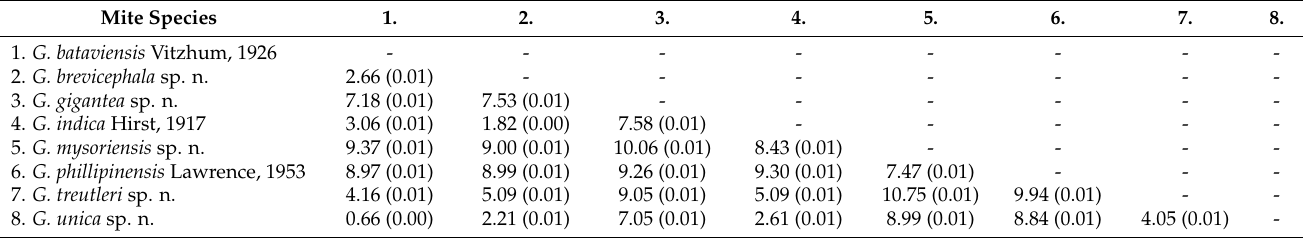
For D2 of 28S rRNA, the interspecies distances ranged from 0.66 to 10.06% (average = 6.9%) (Table 6), and the intraspecies variation ranged from 0 to 2.1 (average = 0.3). The greatest intraspecies genetic variation occurred in G. mysoriensis . For 18S, the intraspecies distances ranged from 0 to 0.36% (average = 0.17%), and the interspecies variation ranged from 0.18 to 1.75% (SD = 0.00, average = 0.86%) (Table 7). The greatest genetic intraspecies variation occurred in G. indica . Table 6. Kimura two-parameter distances (presented as percentages with standard error estimates in parentheses) between D2 sequences of analysed Geckobia species. The analysis included 45 sequences.